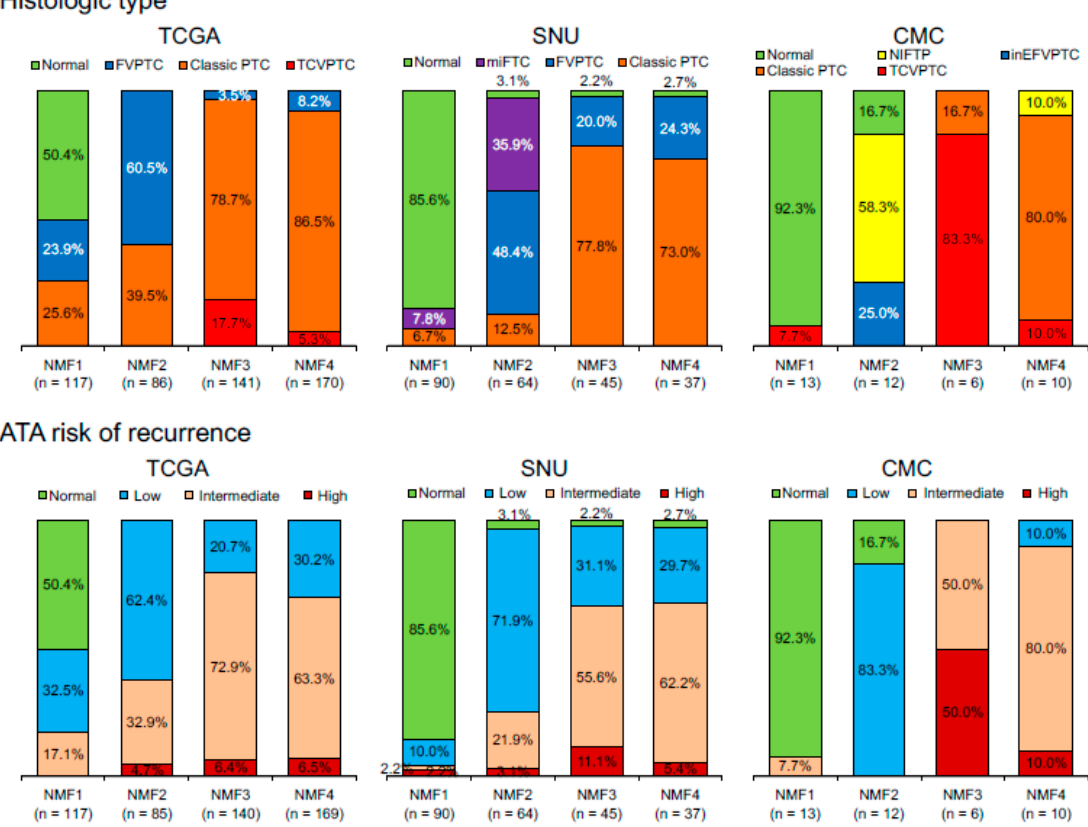
Figure 7. Distribution of histologic types and American Thyroid Association (ATA) risk of recurrence with respect to four NMF clusters in three different datasets. TCGA cohort includes normal thyroid and follicular, classic, and tall cell variants of PTC. SNU cohort includes normal, minimally invasive follicular thyroid carcinoma (miFTC), and follicular variant of PTC (FVPTC) and classic PTC. CMC cohort includes normal, non-invasive follicular thyroid neoplasm with papillary-like nuclear features (NIFTP), and invasive encapsulated follicular (inEFV), classic, and tall cell variants (TCV) of PTC. NIFTP was incorporated into the ATA low risk group.